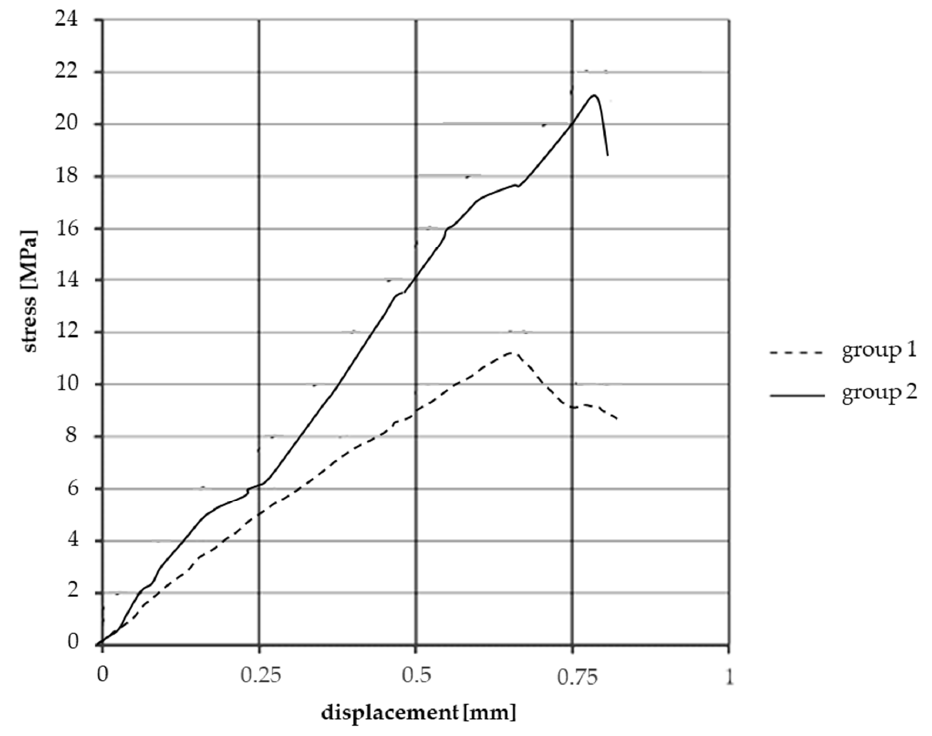
Figure 11. Effects of extrusion on the strength of test samples from the matrix component group.